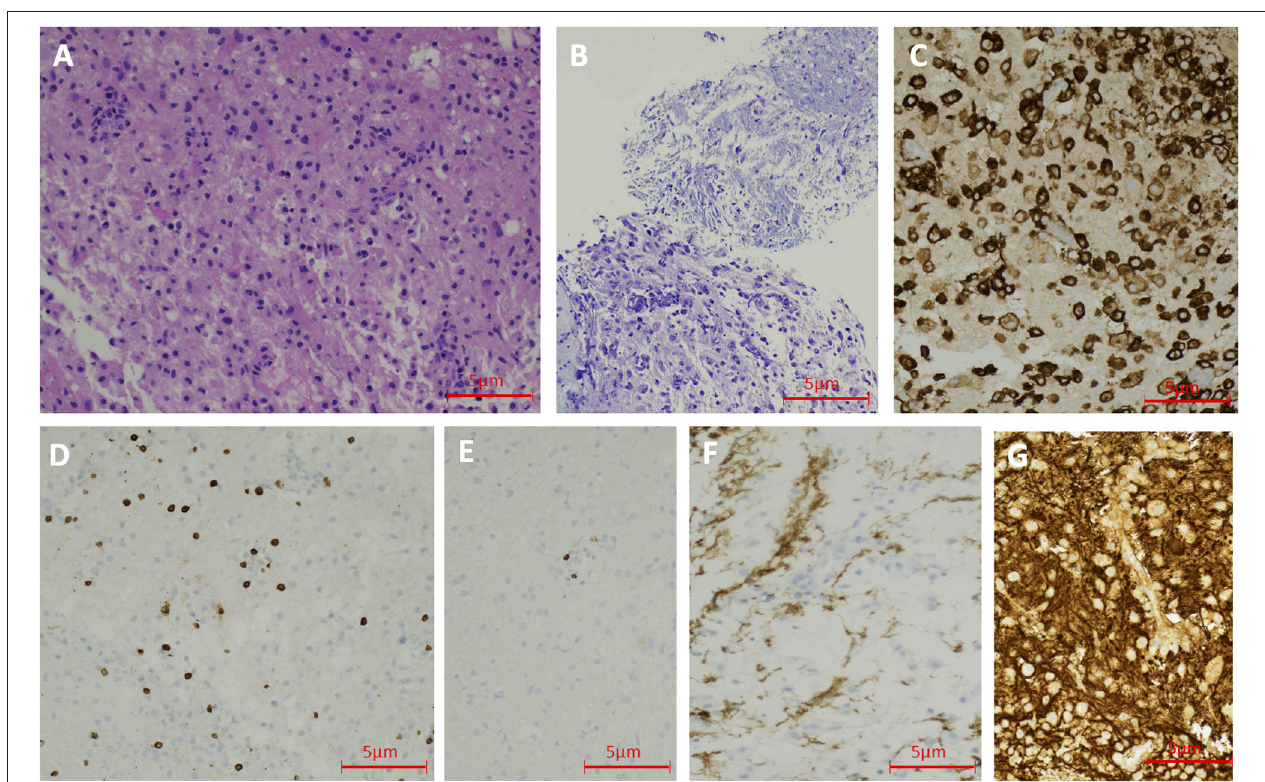
FIGURE 4 | Case 2 Pathology: Hematoxylin and Eosin staining shows lymphohistocytic infiltrate in the brain tissue (200 X) (A) . LFB staining demonstrates demyelination (200 X) (B) . CD163 immunohistochemical stain shows numerous histiocytes (200 X) (C) . CD3 immunohistochemical stain reveals scattered T-lymphocytes (200 X) (D) . CD20 immunohistochemical stain demonstrates rare B-lymphocytes (200 X) (E) . GFAP immunohistochemical stain shows reduced astroglial density in the center of the lesion (200 X) (F) . Neurofilament protein reveals the preservation of axons (200 X) (G) .